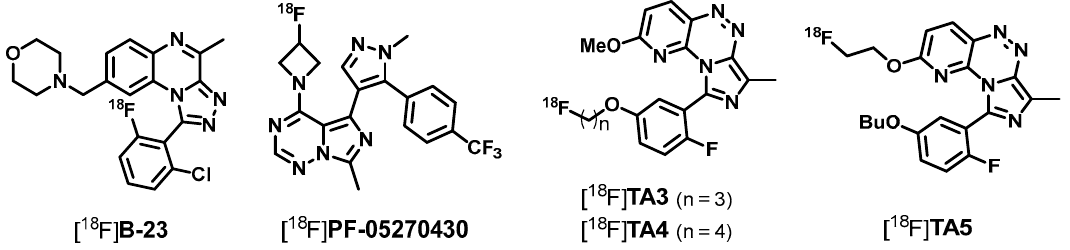
Figure 1. PDE2A radioligands developed by Janssen ([ 18 F] B-23 [6,15]), Pfizer ([ 18 F] PF-05270430 [6,16]), and our group ([ 18 F] TA3 – 5